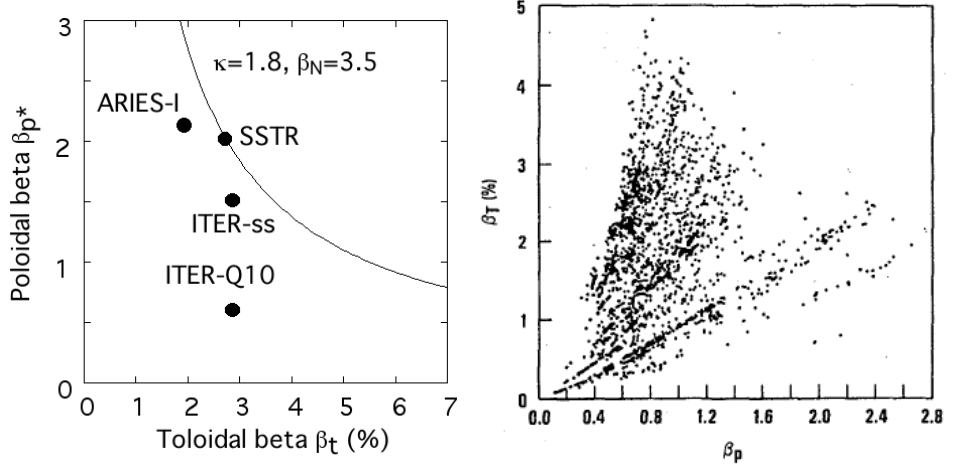
Figure 12. Nominal design points of ITER Q = 10 inductive operation (ITER-Q10), ITER steady-state operation (ITER-ss), SSTR and ARIES-I on a (  reference line for  = 3.5 and  = 1.8. (left). Experimentally confirmed operating regime in N (  ,  ) to confirm Troyon scaling in Doublet III (right) p t